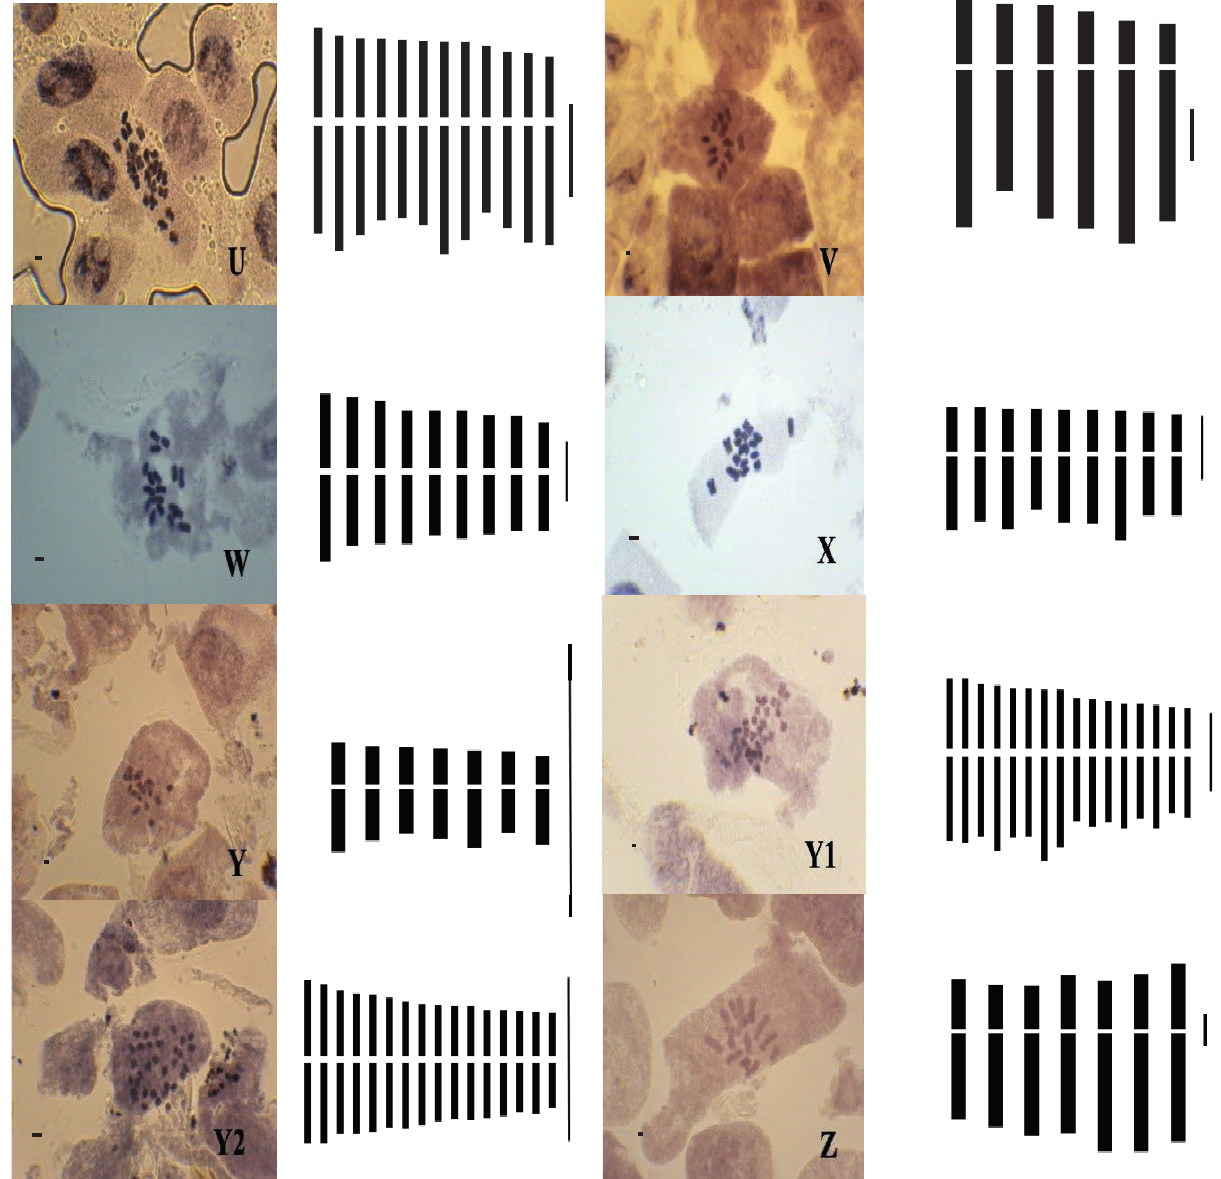
Figure 3. Somatic metaphase chromosome, Ideogram of each population is on the right side of the image: U: Triglochin maritima (Jam val- ley) (2 n = 24); V: Triglochin maritima (Bolaghvar) (2 n = 12); W: Tripleurospermum disciforme (Bostanabad) . (2 n = 18); X: Tripleurospermum disciforme (Jam valley( (2 n = 18); Y: Veronica filiformis (2 n = 14); Y1: Veronica orientalis (Arshad Chamani) (2 n = 32); Y2: Veronica orienta- lis (Bostanabad) (2 n = 32); Z: Vicia variabilis (2 n = 14). Scale bar: 1